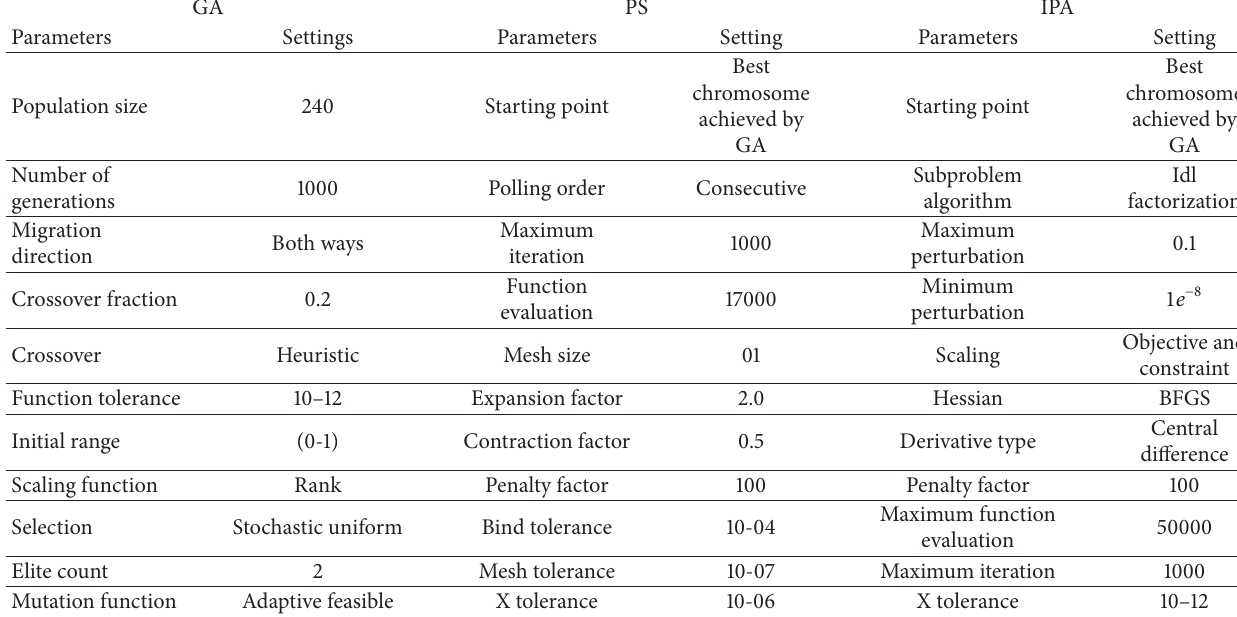
Table 1: Parameter setting for GA, PS, and IPA.